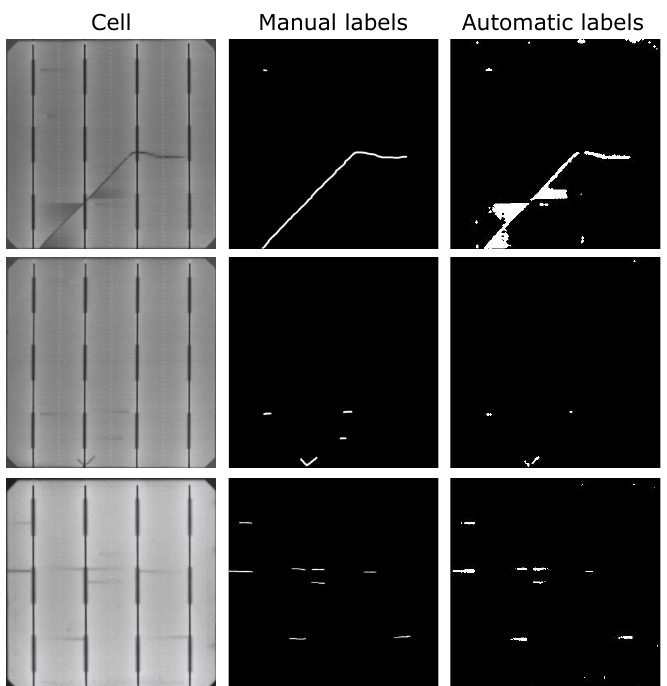
Figure 9. Manual and automatic labeling for different samples. The automatic labeling kept the segmentation of the labeled defects, but at the same time introduced some additional areas. This is especially noticeable in the samples from the first row, where the manual labeling only considered the defect itself, but the automatic labeling also considered the darker areas created by the effect of the